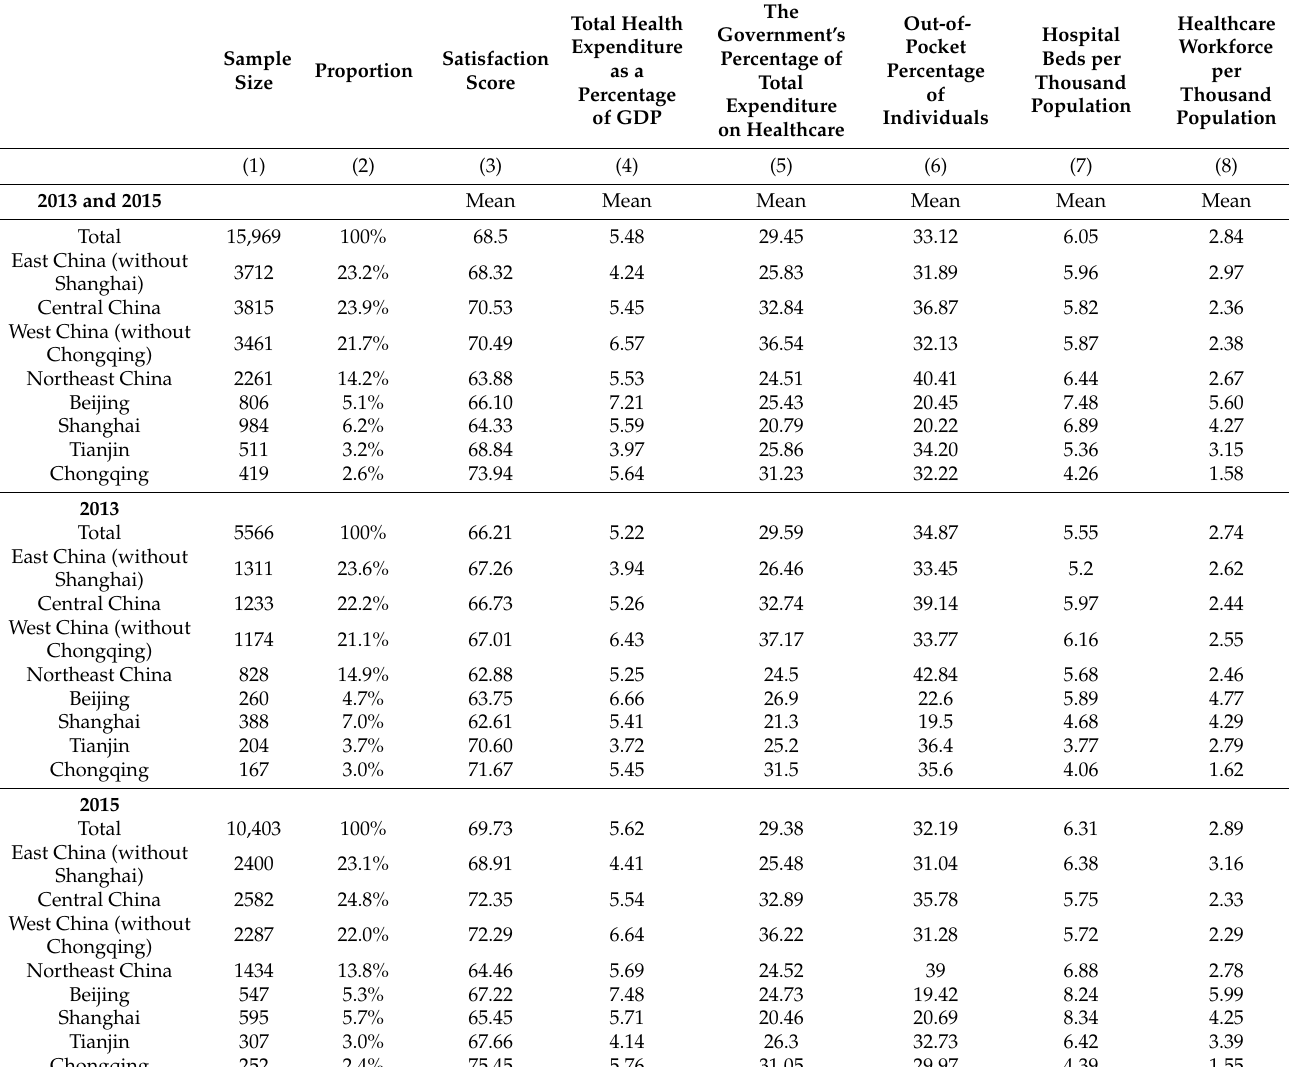
Table 1. Descriptive statistics of the satisfaction scores in Chinese General Social Survey (CGSS) and health resources (Year 2013 and